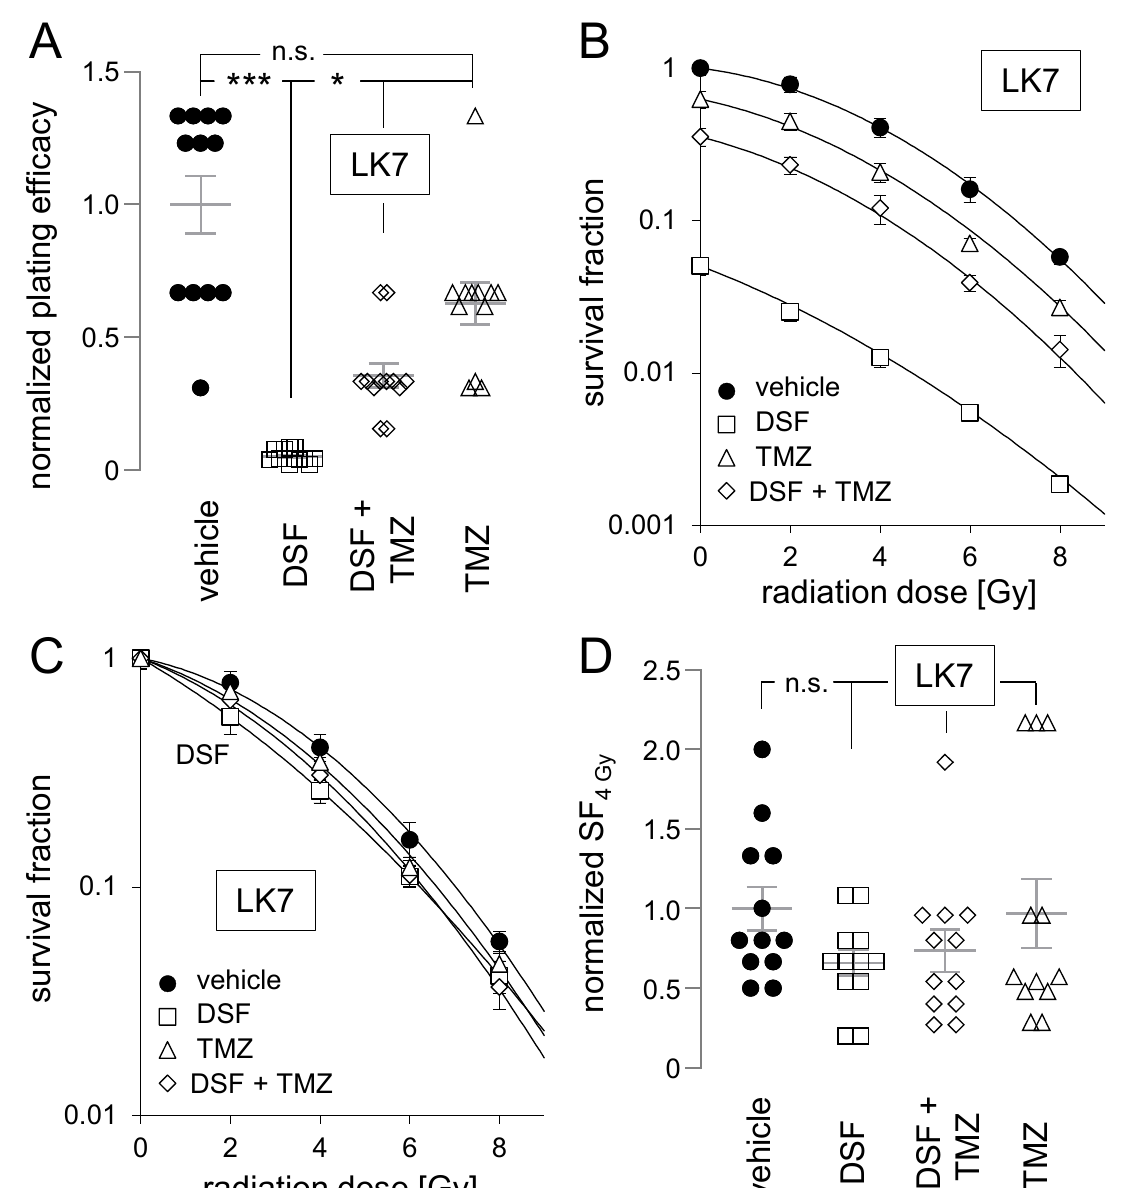
Figure 6. Disulfiram impairs clonogenic survival of LK7 cells. Neither disulfiram nor temozolomide radiosensitizes LK7 cells, and temozolomide attenuates the clonogenic survival-diminishing effect of disulfiram. ( A – D ) Dependence of normalized plating efficiency ( A ), vehicle-0 Gy control-normalized survival fraction ( B ), experimental arm-specific 0 Gy control-normalized survival fraction ( C ), and survival fraction after irradiation with 4 Gy (SF 4 Gy , ( D )) of LK7 cells on radiation dose (in ( B , C )) and on cotreatment (in ( A – D )) with vehicle (closed circles), disulfiram (DSF, 100 nM, open squares), temozolomide (TMZ, 30 µ M, open triangles) and DSF + TMZ (open diamonds). Shown are means ( ± SE, n = 12) and additionally individual values in ( A , D ). Mean absolute ( ± SE, n = 12) plating efficiency of 0 Gy/vehicle-treated LK7 cells was 0.77 ± 0.29. *, ***, and n.s. indicate p ≤ 0.05, p ≤ 0.01, and not significantly differing, respectively, as calculated by nonparametric Kruskal–Wallis with Dunn’s multiple comparison test. To maintain clarity, significance asterisks were not sketched in ( B ).